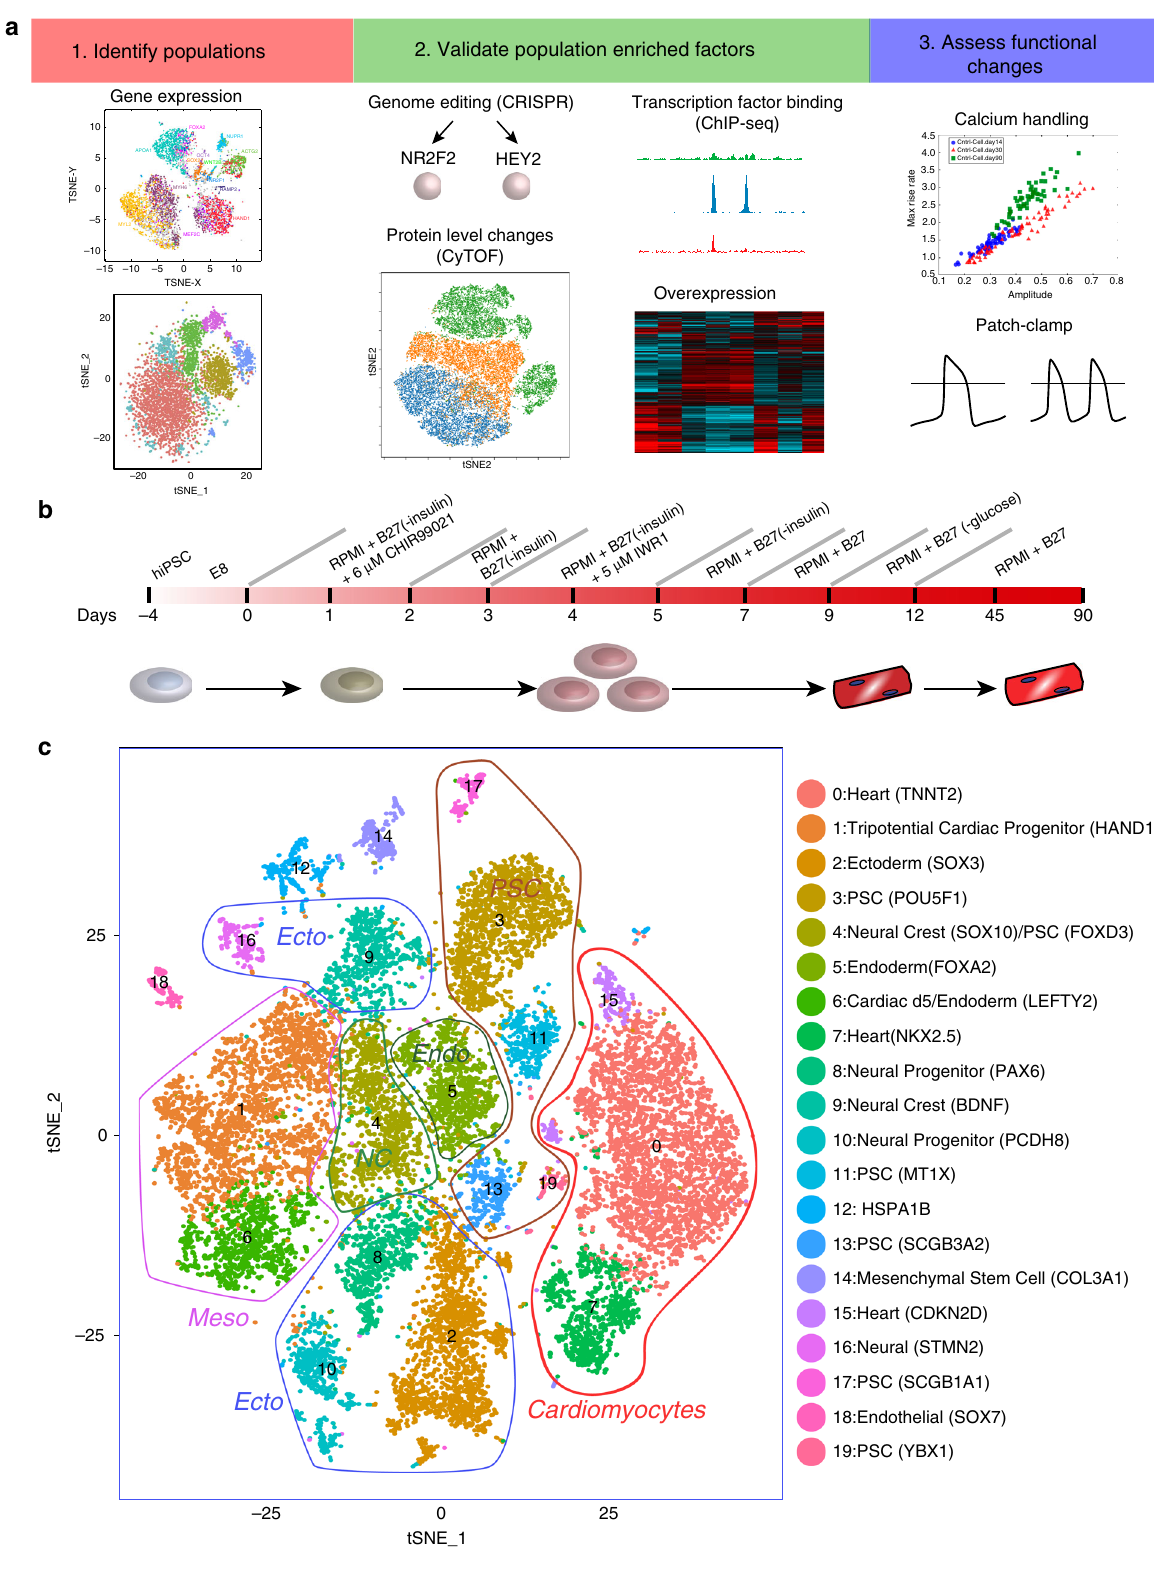
Factor and YRPW Motif 2 ( HEY2 ). ICGS clusters using 10X single-cell RNA-seq from day 14 and day 45 cardiomyocytes also revealed the expression of these transcription factors (pre- dominantly HEY2 and MYL2 expression) in later stage (day 45) cardiomyocytes compared to earlier time point cardiomyocytes